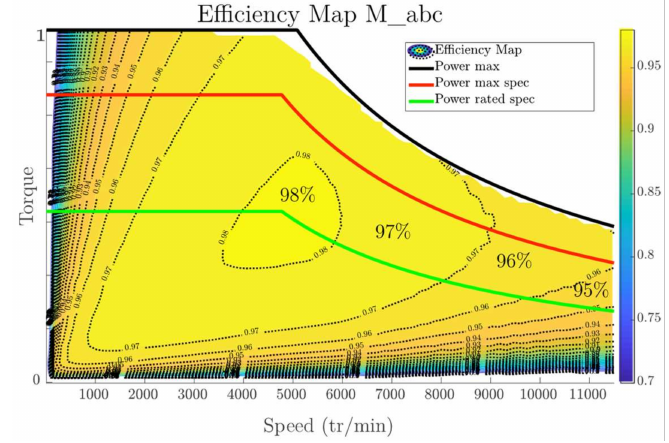
Figure 21. Efficiency map for the machine optimized by the “abc